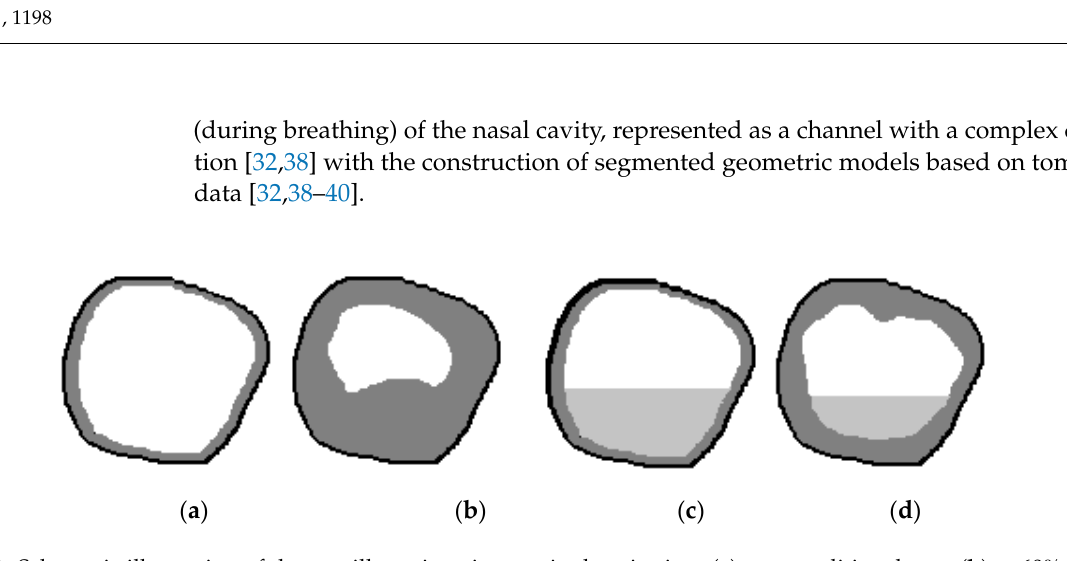
Figure 4. Schematic illustration of the maxillary sinus in a sagittal projection: ( a ) at a conditional rate, ( b ) at 60% filled sinus cavity with polyposis content; ( c ) when filling the sinus by 40% liquid content; ( d ) filling of the sinus with liquid and polyposis contents by 30% and 20%, respectively. Sensors 2021 , 21 , x FOR PEER REVIEW